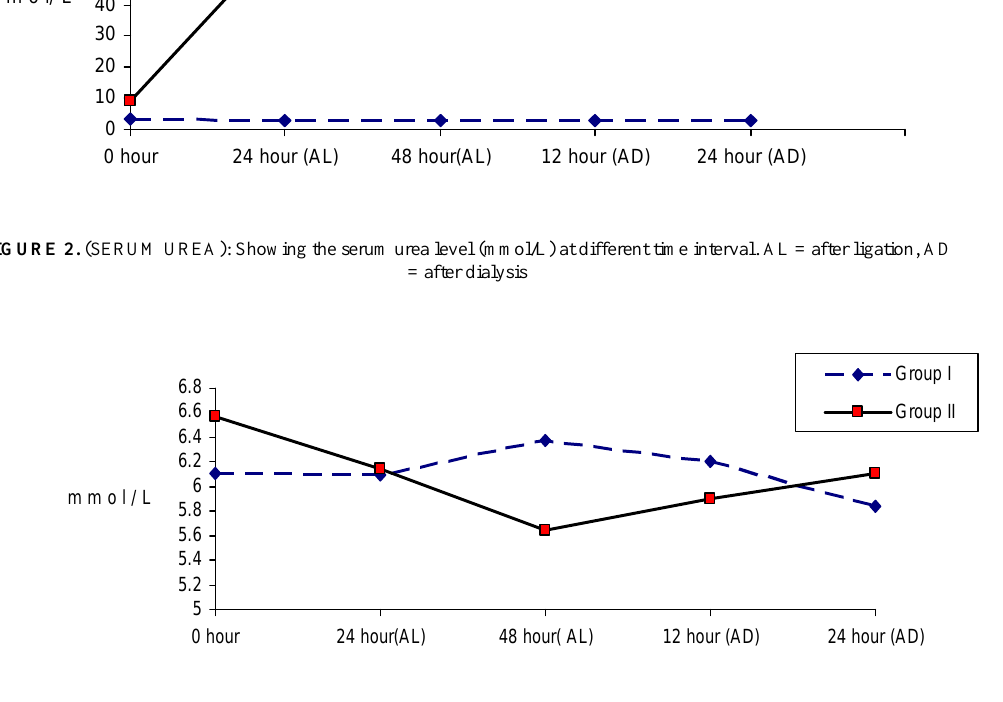
FIGURE 3. (BLOOD GLUCOSE): Showing the Blood Glucose level (mmol/L) at different time interval. AL = after ligation, AD = after